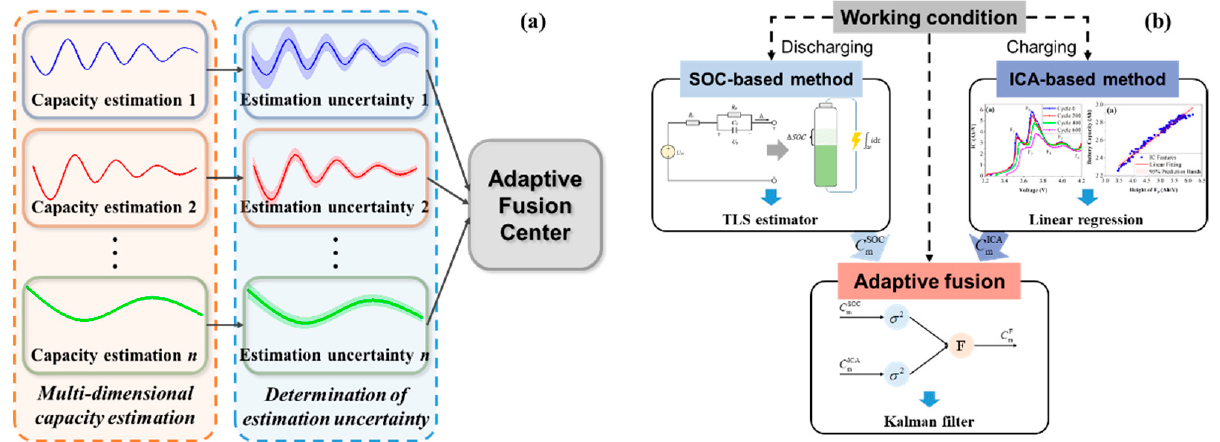
Figure 1. Battery capacity estimation and fusion. ( a ) A general framework of multi-dimensional capacity fusion. ( b ) The specific implementation in this study.